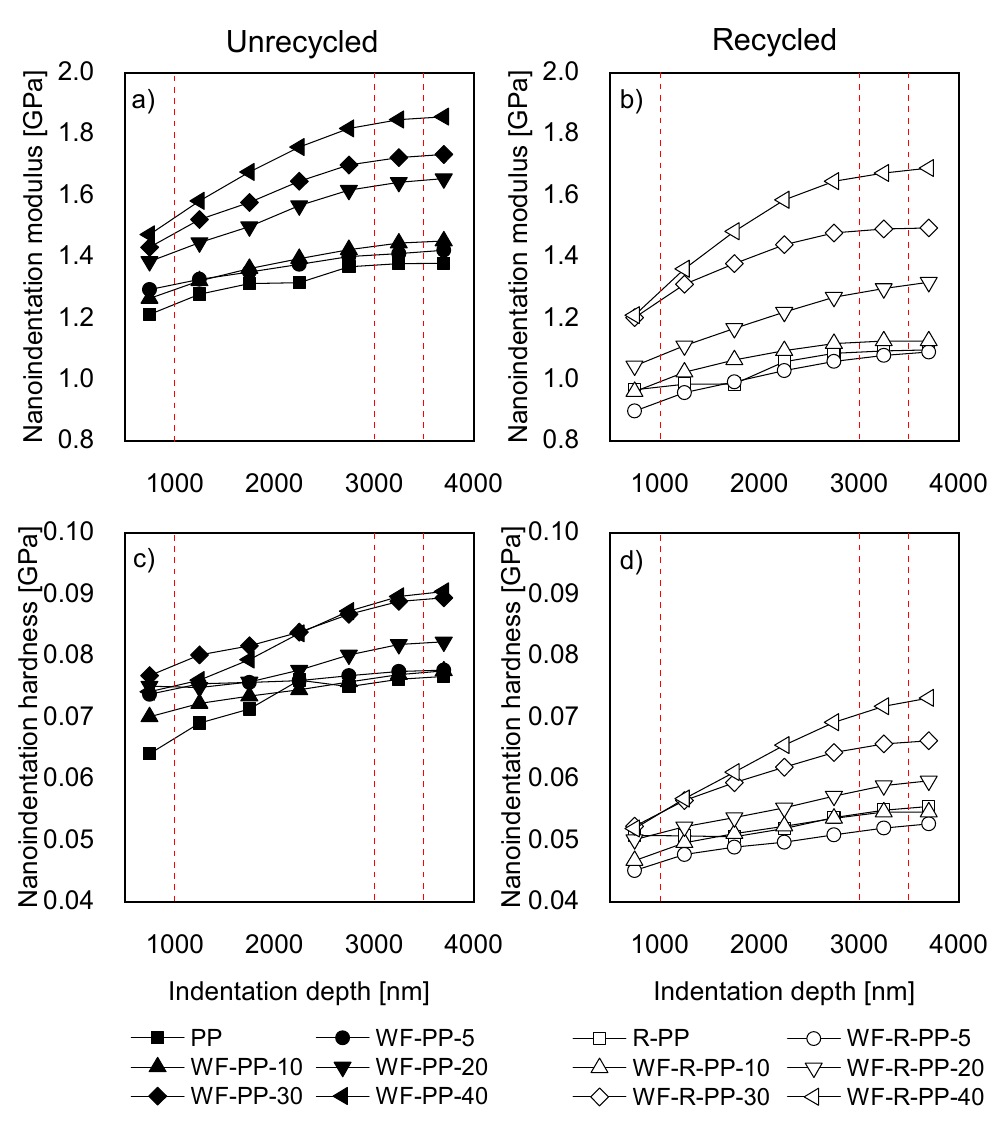
Figure 14. Nanoindentation modulus as a function of indentation depth for ( a ) unrecycled and ( b ) recycled materials. Nanoindentation hardness as a function of indentation depth for ( c ) unrecycled and ( d) recycled materials.